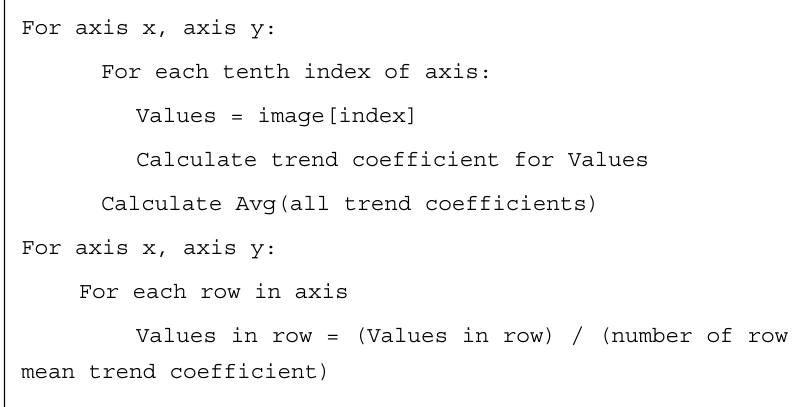
For axis x, axis y: